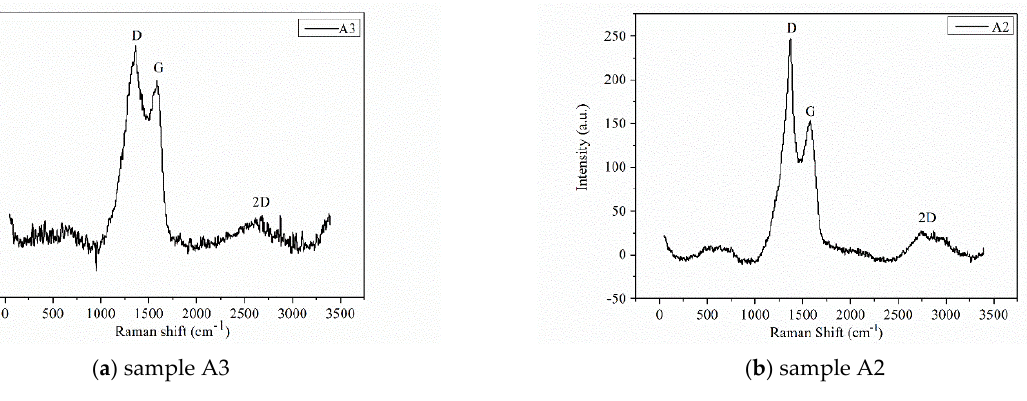
Figure 2. Raman spectrogram of samples A2 and A3.